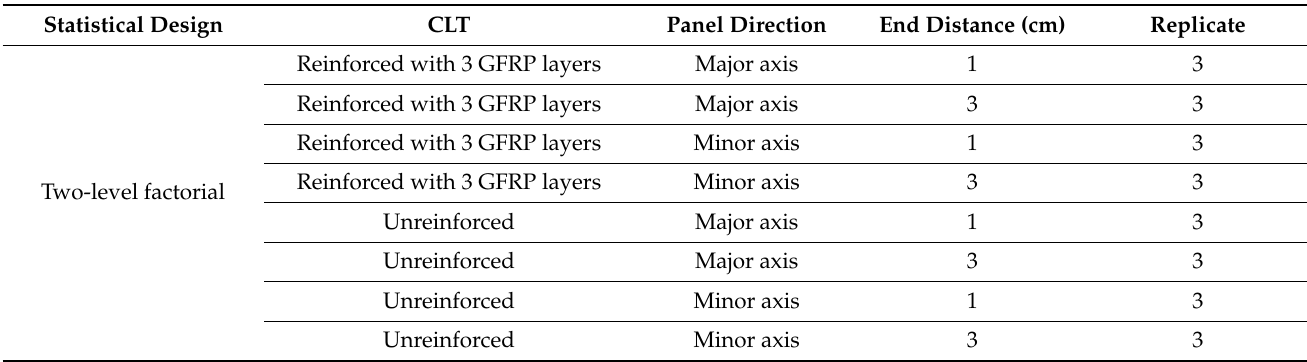
Table 2. Statistical groups for investigating the effect of reinforcement, end distance, and panel strength direction on lateral resistance.